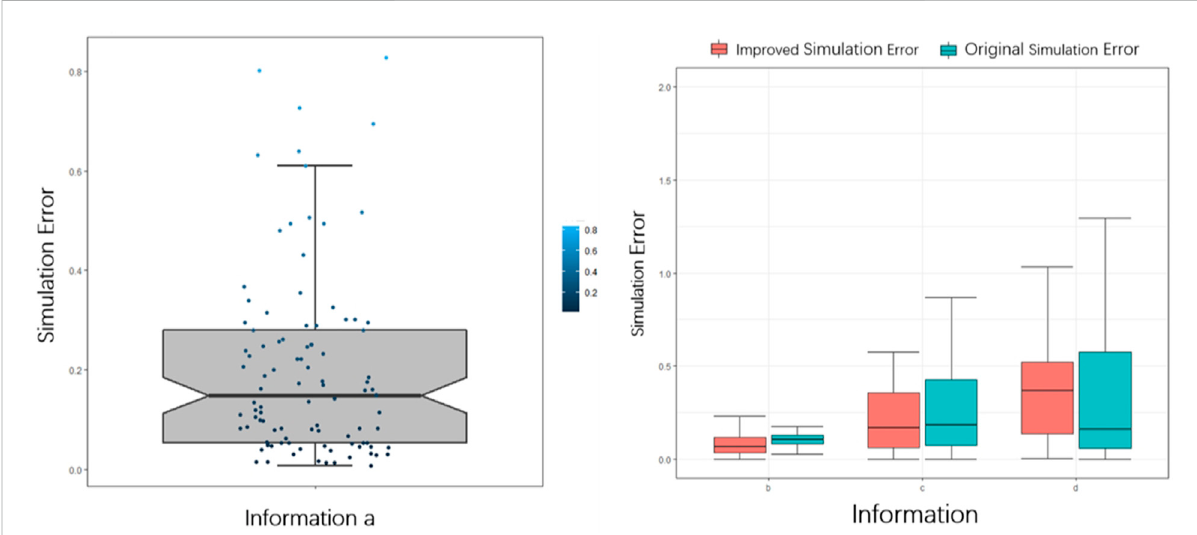
FIGURE 7 Boxplotsofsimulationerrorsoftweet(a),(b),(c),and(d).Theleft fi gurecorrespondstotheboxplotofsimulationerroroftweet(a),andtheright fi gure corresponds to the box plot of simulation error of tweet (b), (c), (d) respectively. The distribution of the intensity error of tweet (a) simulated by the improved Hawkes model ranges from 0.1 to 0.3, with a mean value of about 0.2; the distribution of the simulation error of tweet (b) ranges from 0.1 to 0.2, with amean valueof about0.1; the distribution of the simulation error oftweet (c) ranges from 0.1 to 0.4, with a mean value of about 0.26; for tweet (d), which has more burst peaks in the information propagation, the simulation error is enlarged, and it is mainly concentrated between 0.1 and 0.4, but the simulation error still maintains the mean value of 0.35. The stage on the left side of the vertical dashed line and the prediction stage on the right